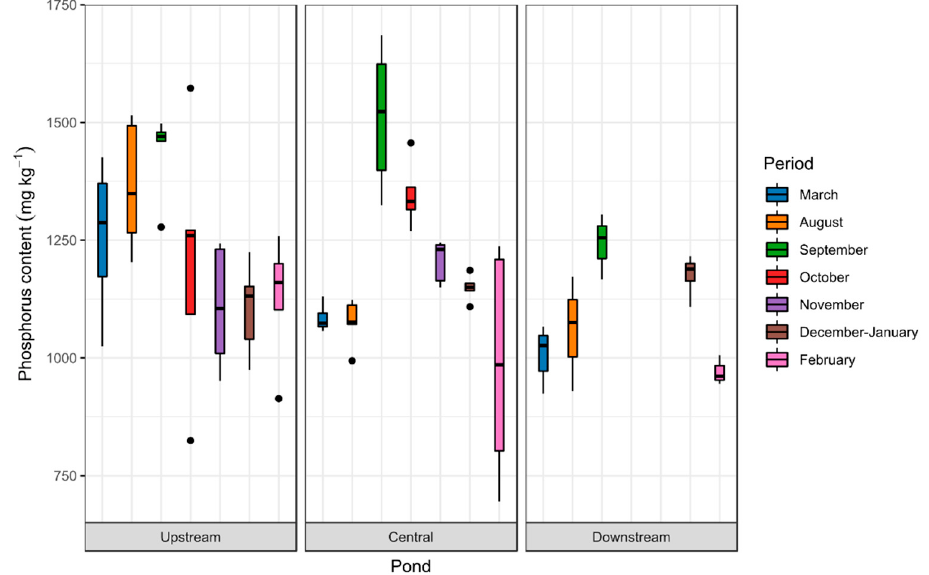
Figure 5. Boxplots showing the range of phosphorus content (mg kg − 1 ) of deposited sediment in